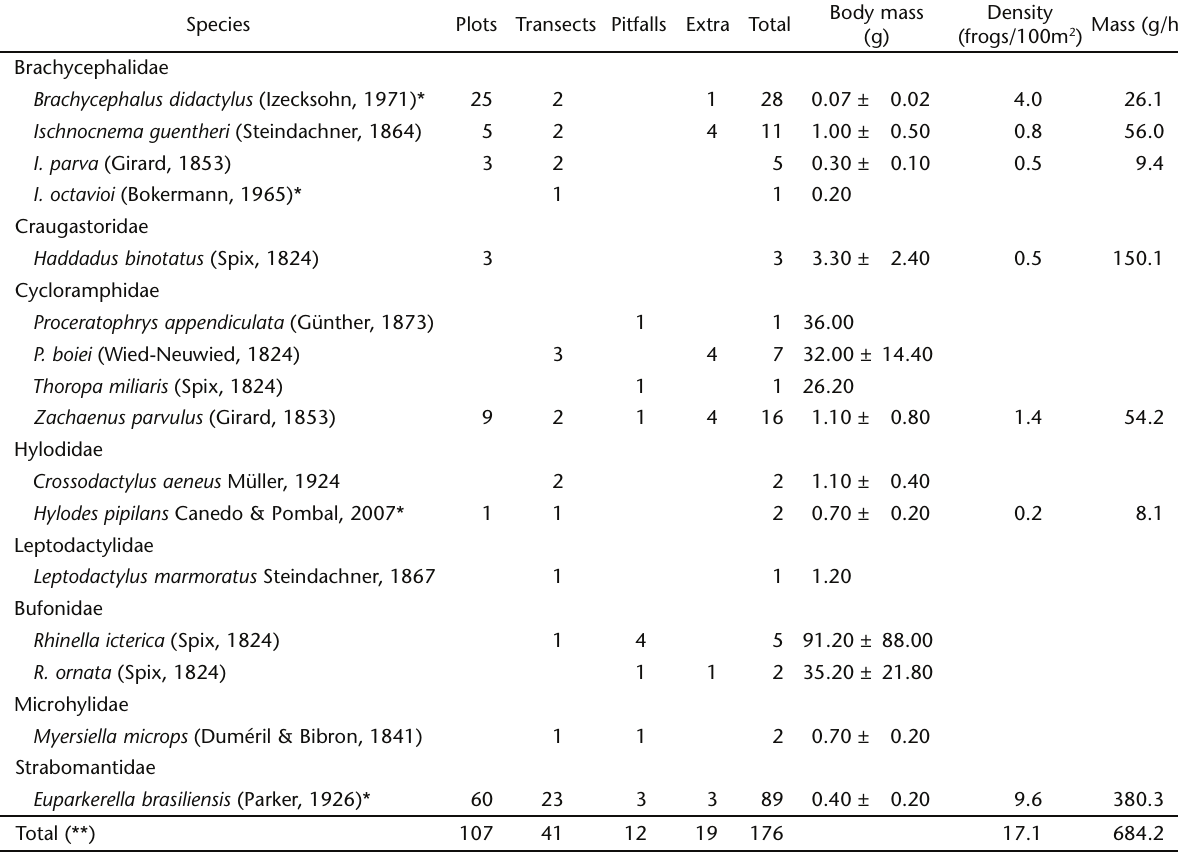
Table I. Number of individuals recorded for each sampling method and mean body mass (± one standard deviation) of each species, and estimated density and mass per area of frogs recorded in the leaf litter of an Atlantic Rainforest area within the Parque Estadual dos Três Picos, in southeastern